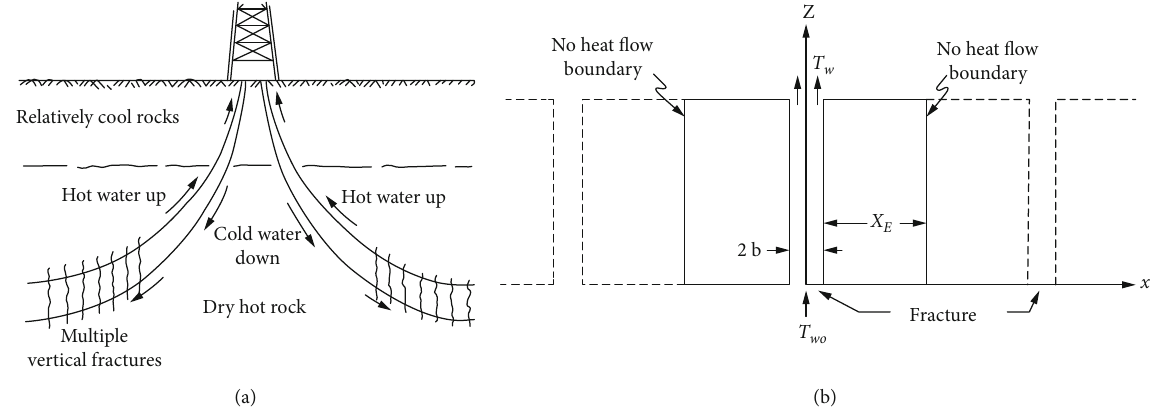
Figure 1: (a) Schematic diagram of heat extraction from multiple fractures in hot rock (b) model for fractured hot rock (extracted from